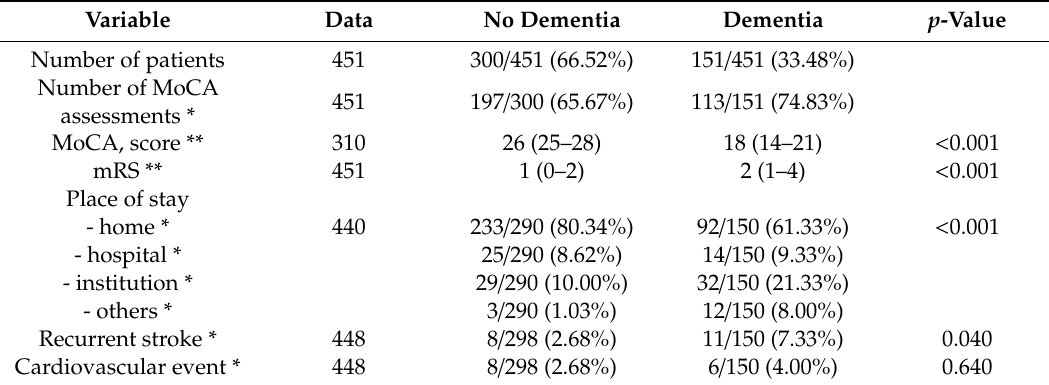
Table 3. Characteristics of the examined patients at the twelve-month